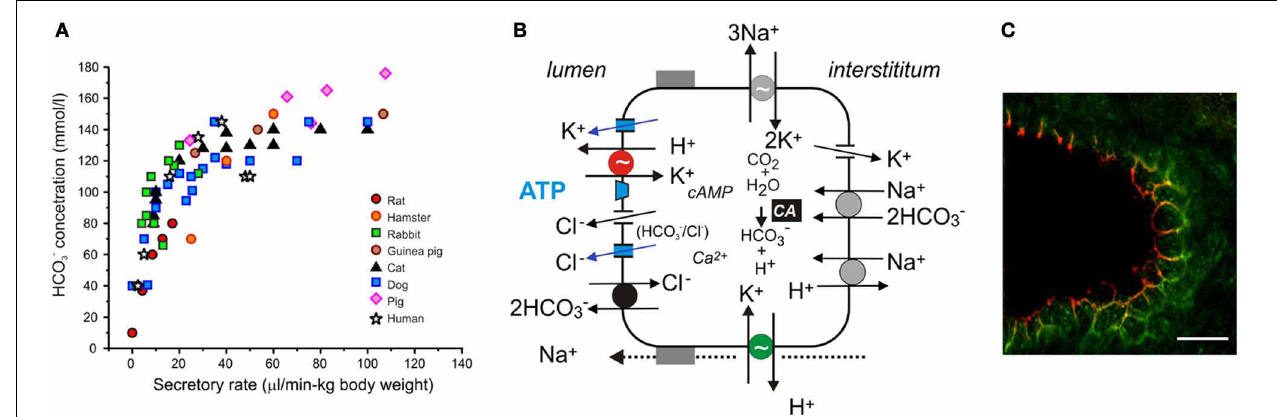
certain conditions, through Cl − channels. The luminal Cl − channels are CFTR and TMEM16A (see text). There are a number of K + channels expressed on the luminal and basolateral membranes, e.g., K Ca 3.1, K Ca 1.1, KCNQ1 (see text). The luminal and basolateral H + -K + -ATPases are indicated in red and green, and supposedly contribute to the luminal buffer zone and the H + efflux to intersititum, respectively. Other ion channels and transporters, such as NHE3, SLC26A3, NBC3, NKCC1, and aquaporins have a differential distribution in the duct tree and for simplicity are not included in the model. (C) Immunolocalization of the gastric (red) and non-gastric (green) H + -K + pumps in rat pancreatic duct. The bar is 20 μ m. Modified from Novak et al.,